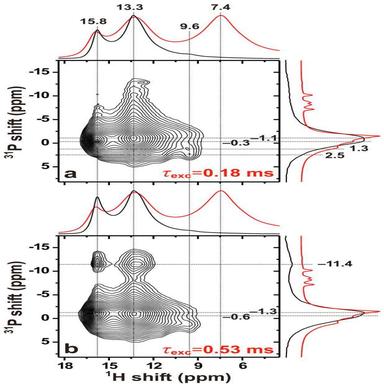
1 H D-HMQC NMR correlation spectra acquired at 34.00 kHz MAS from the MonB specimen, using MQC excitation periods of (a) 176 μs and (b) 529 μs, and shown together with projections along the 1 H (horizontal) and 31P (vertical) dimensions at the top and to the right of the 2D NMR spectrum. Directly excited ("single-pulse") 1 H and 31P MAS NMR spectra recorded at 14 kHz MAS are displayed by red traces. The 2D peaks at δH ≈ 9.6 ppm and δP = ppm originate from NaH2PO4 (see section. (F